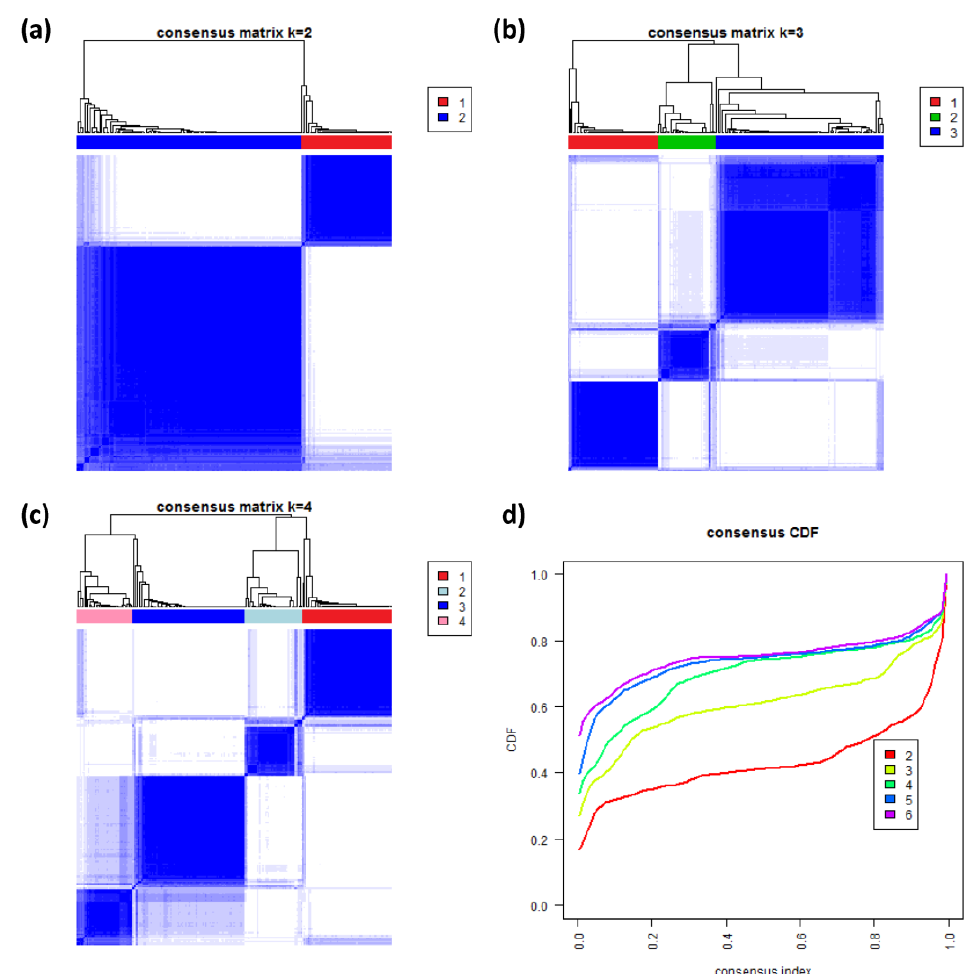
Figure 8. Consensus clustering: ( a (cid:177) c ) Cluster-heatmaps of the consensus matrices for class numbers ranging from two to four, respectively. Pairs of samples frequently found in one joint class accumulate in the blue regions along the diagonal of the map. ( d ) Cumulative distribution function (CDF) for class numbers ranging from two to